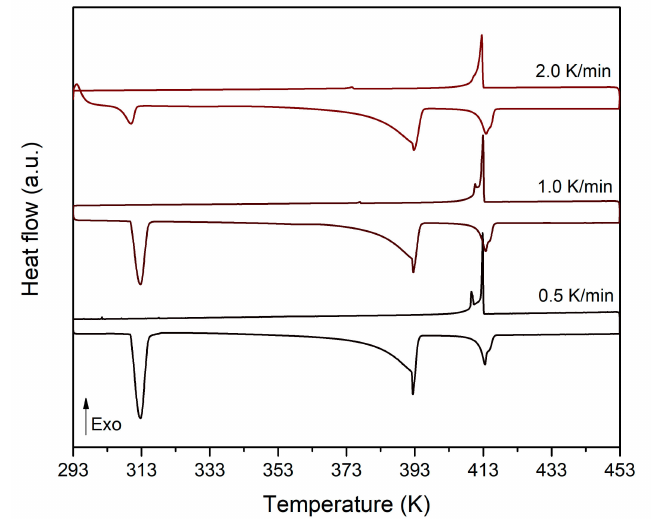
Figure 9. DSC thermograms obtained for di ff erent NPG 0.515 TRIS 0.485 samples submitted to di ff erent heating / cooling rates (0.5 to 2 K / min) between 293 K and 453